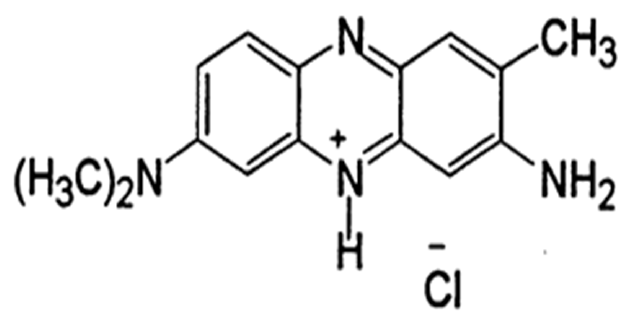
Figure 1. Chemical structure of Basic Red 5. Table 1. Physico-chemical properties of Basic Red 5 .